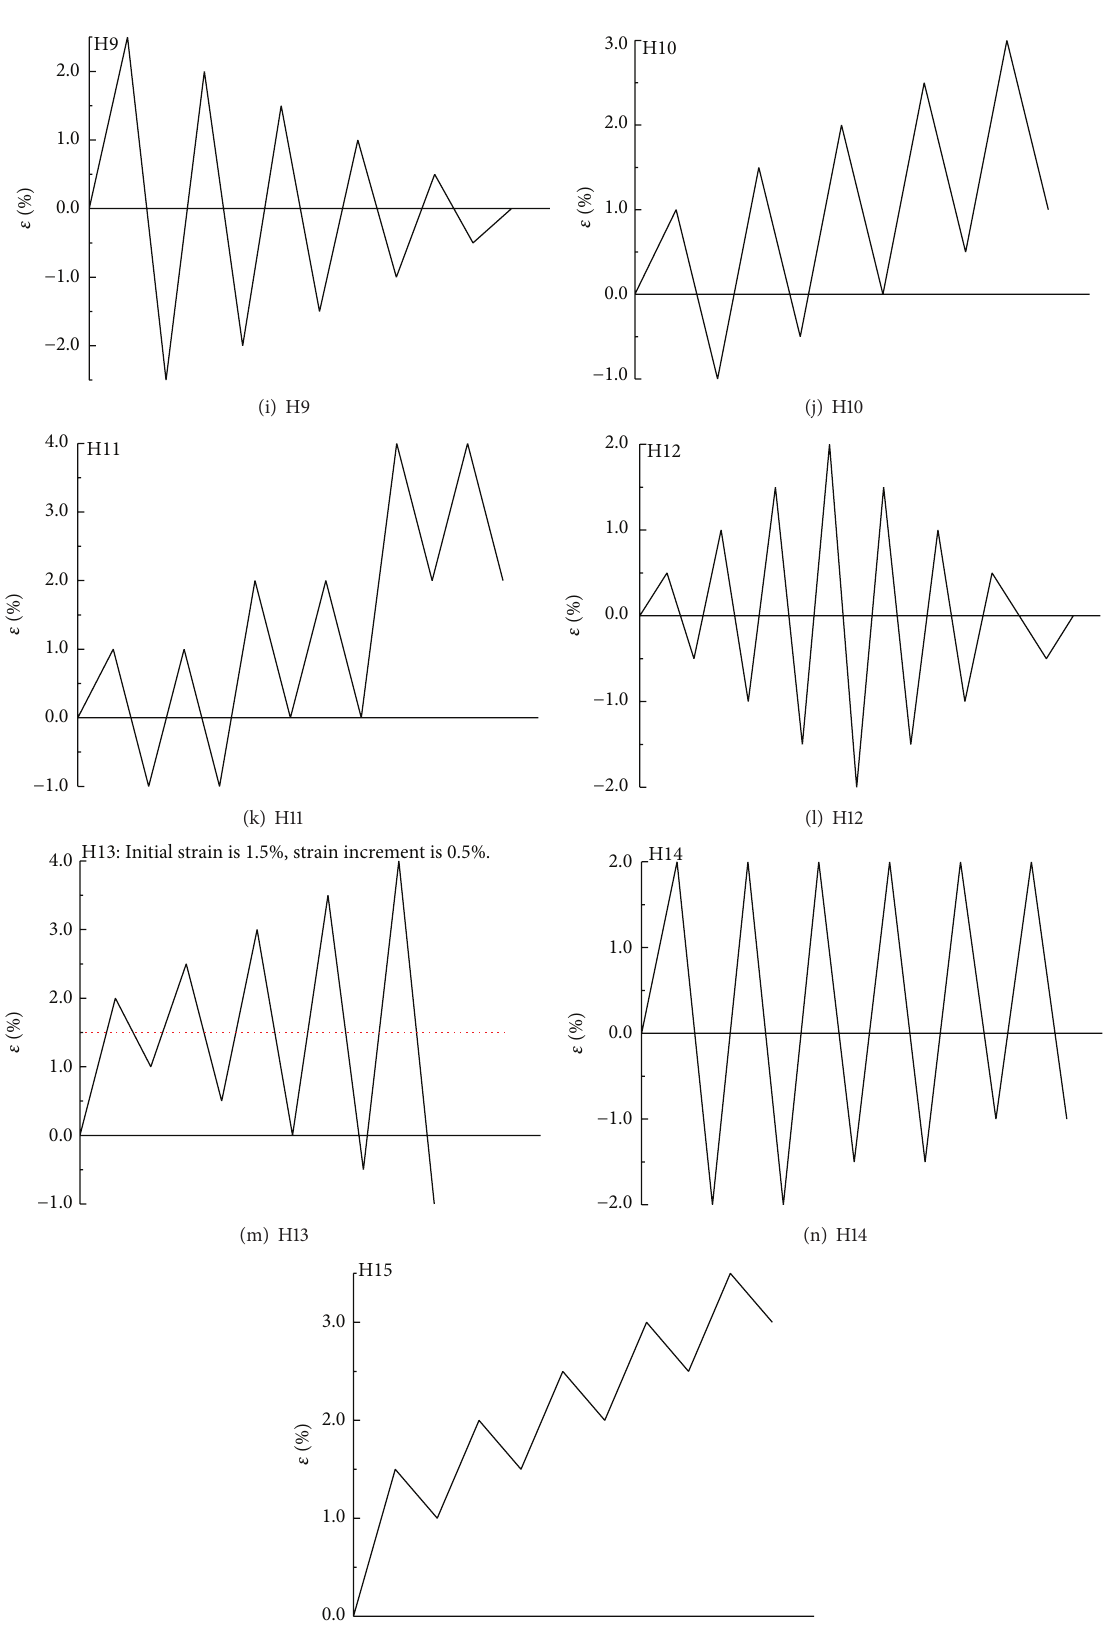
Figure 3: Cyclic loading